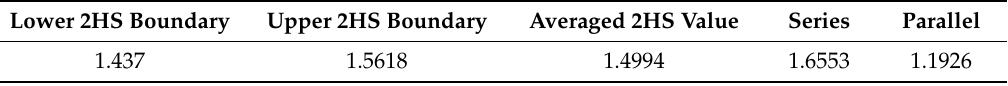
Table 13. Two-phase thermal conductivity approximations—cement system C. Lower 2HS Boundary Upper 2HS